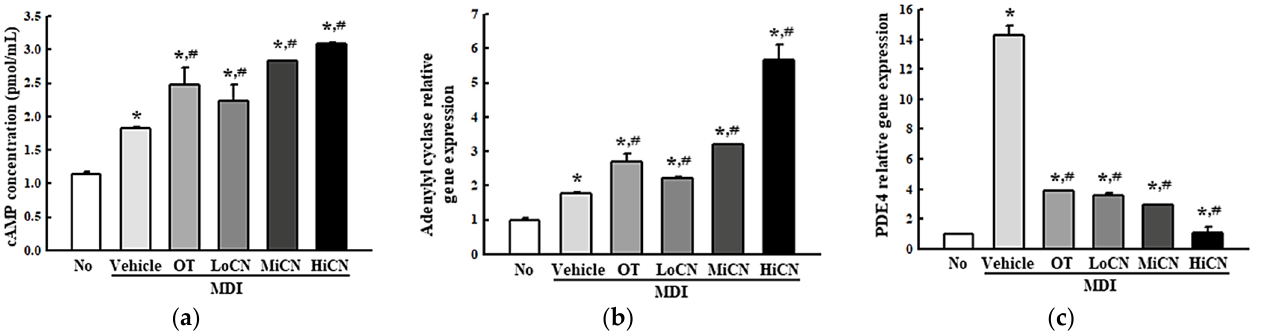
Figure 6. cAMP-mediated pathway analyses. ( a ) Relative level of cAMP concentration. After collecting the cell lysates from MDI-stimulated 3T3-L1 adipocytes treated with α -cubebenol, the cAMP concentration was measured using an ELISA assay. Two to three wells per group were used to collect the cell lysates, and the assay was measured in duplicate. ( b , c ) cAMP regulators analysis. After collecting the total RNA from MDI-stimulated 3T3-L1 adipocytes treated with α -cubebenol, the mRNA levels of adenylyl cyclase ( b ) and PDE4 ( c ) were quantified by RT-qPCR, as described in Materials and Methods. Two to three dishes per group were used to prepare the total RNAs, and qRT-PCR were assayed in duplicate for each sample. The data represent the means ± SD of three replicates. * indicates p < 0.05 compared to the No treated group. # indicates p < 0.05 compared to the MDI + Vehicle treated group. OT, orlistat; MDI, adipogenic cocktail consisting of 3-isobutyl-1-methylxanthine, dexamethasone, and insulin; LoCN, low concentration (7.5 μ g/mL) of α -cubebenol; MiCN, middle concentration (15 μ g/mL) of α -cubebenol; HiCN, high concentration (30 μ g/mL) of α -cubebenol.